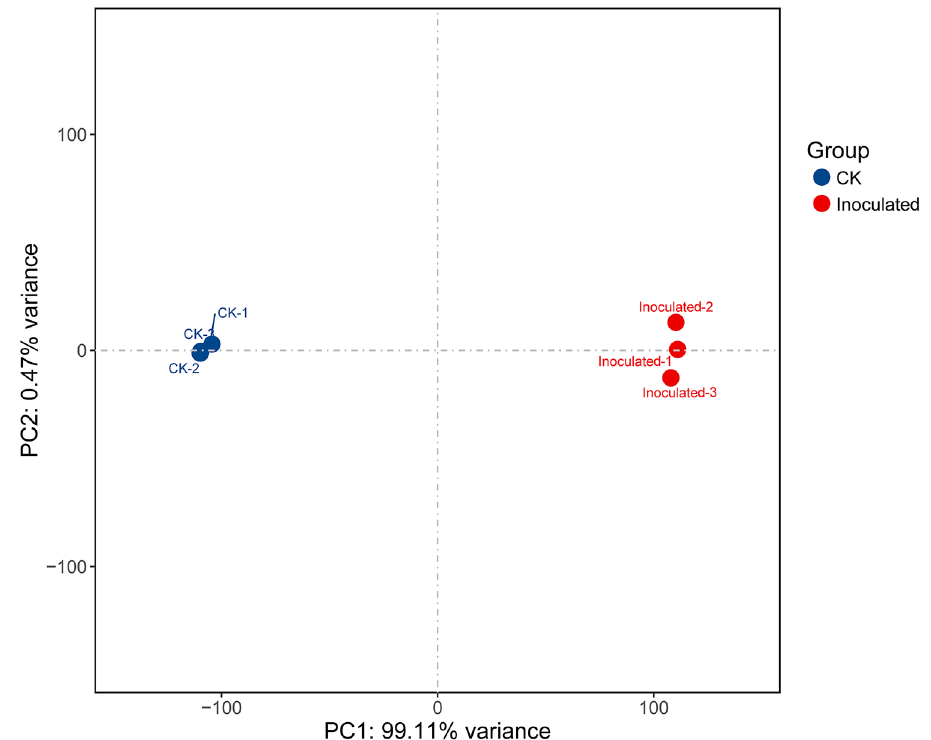
Figure 3. Principal component analysis (PCA) for gene expression patterns. The first and second PCAs explained 99.11% and 0.47% of the variance, respectively. CK indicates mock plants, and Inoculated indicates plants infected by T.